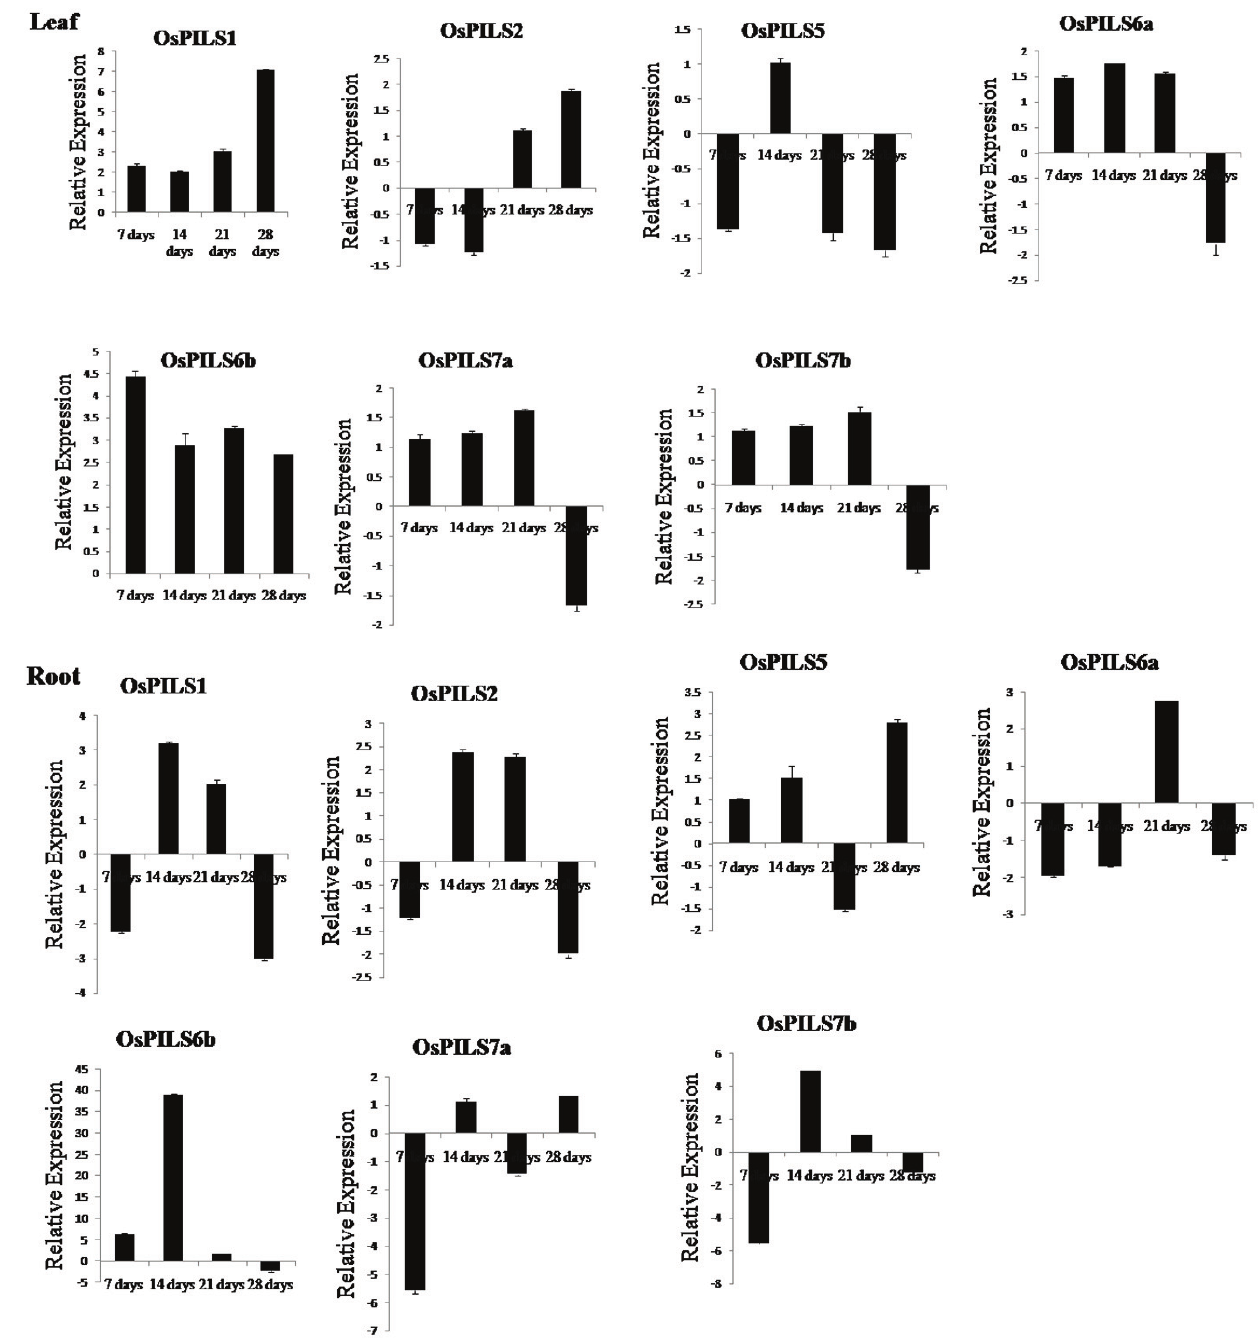
Figure 8. Relative expression of OsPILS genes in leaf and root tissues treated with 5 µM BAP (6-benzylaminopurine).Maximum of OsPILS genes were up-regulated in leaf tissues. Specifically, the OsPILS1 and OsPILS6b genes were up-regulated at seven, 14, and 21 days in cytokinin treated leaves. In cytokinin treated root tissues, the majority of OsPILS was up- regulated at 14 and 21